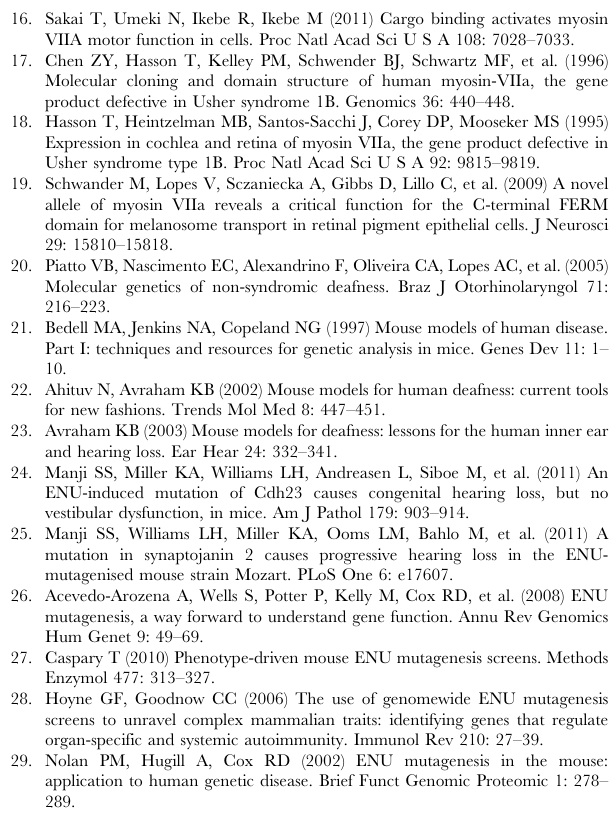
Figure S1 Hearing profile of 4 and 24 wk ( A ) Myo7a + / + (n= 16, n =13), Myo7a I487N/ + ewaso (n= 16, n= 22), Myo7a I487N/I487N ewaso (n =13, n= 18) and ( B ) Myo7a + / + , Myo7a F947I/ + dumbo (n= 13, n =14) and Myo7a F947I/F947I dumbo (n= 12, n= 25) mice at 24 weeks of age.*p = 9.8 6 10 2 12 . (TIF) Figure S2 Hearing profile of Myo7a F947I/F947I dumbo strain from 4 to 24 weeks of age. 4wk (n= 12), 8wk (n= 17), 12wk (n =24), 24wk (n= 25). *p =7.2 6 10 2 20 . (TIF) Figure S3 SEM analysis of P5 cochlear sensory epithelium from Myo7a mutant strains. Apical, middle and basal cochlear turns were examined in Myo7a + / + (A, B and C), Myo7a I487N/I487N (D, E and F) and Myo7a F947I/F947I (G, H and I) mice at P5. OHC, outer hair cells; IHC, inner hair cells. Stereocilia on the occasional OHC appear to be misorientated in Myo7a I487N/I487N ewaso mice at this age (asterix in D), and more commonly in Myo7a F947I/F947I dumbo mutants. Scale bar; 5 m M. Figure S4 SEM analysis of 2 week old cochlear sensory epithelium from Myo7a mutant strains. Apical, middle and basal cochlear turns were examined in Myo7a + / + (A, B and C), Myo7a I487N/I487N ewaso (D, E and F) and Myo7a F947I/F947I dumbo (G, H and I) mice at 2 weeks. Misorientation of stereocilia bundles can be seen in both strains, particularly at the basal level in